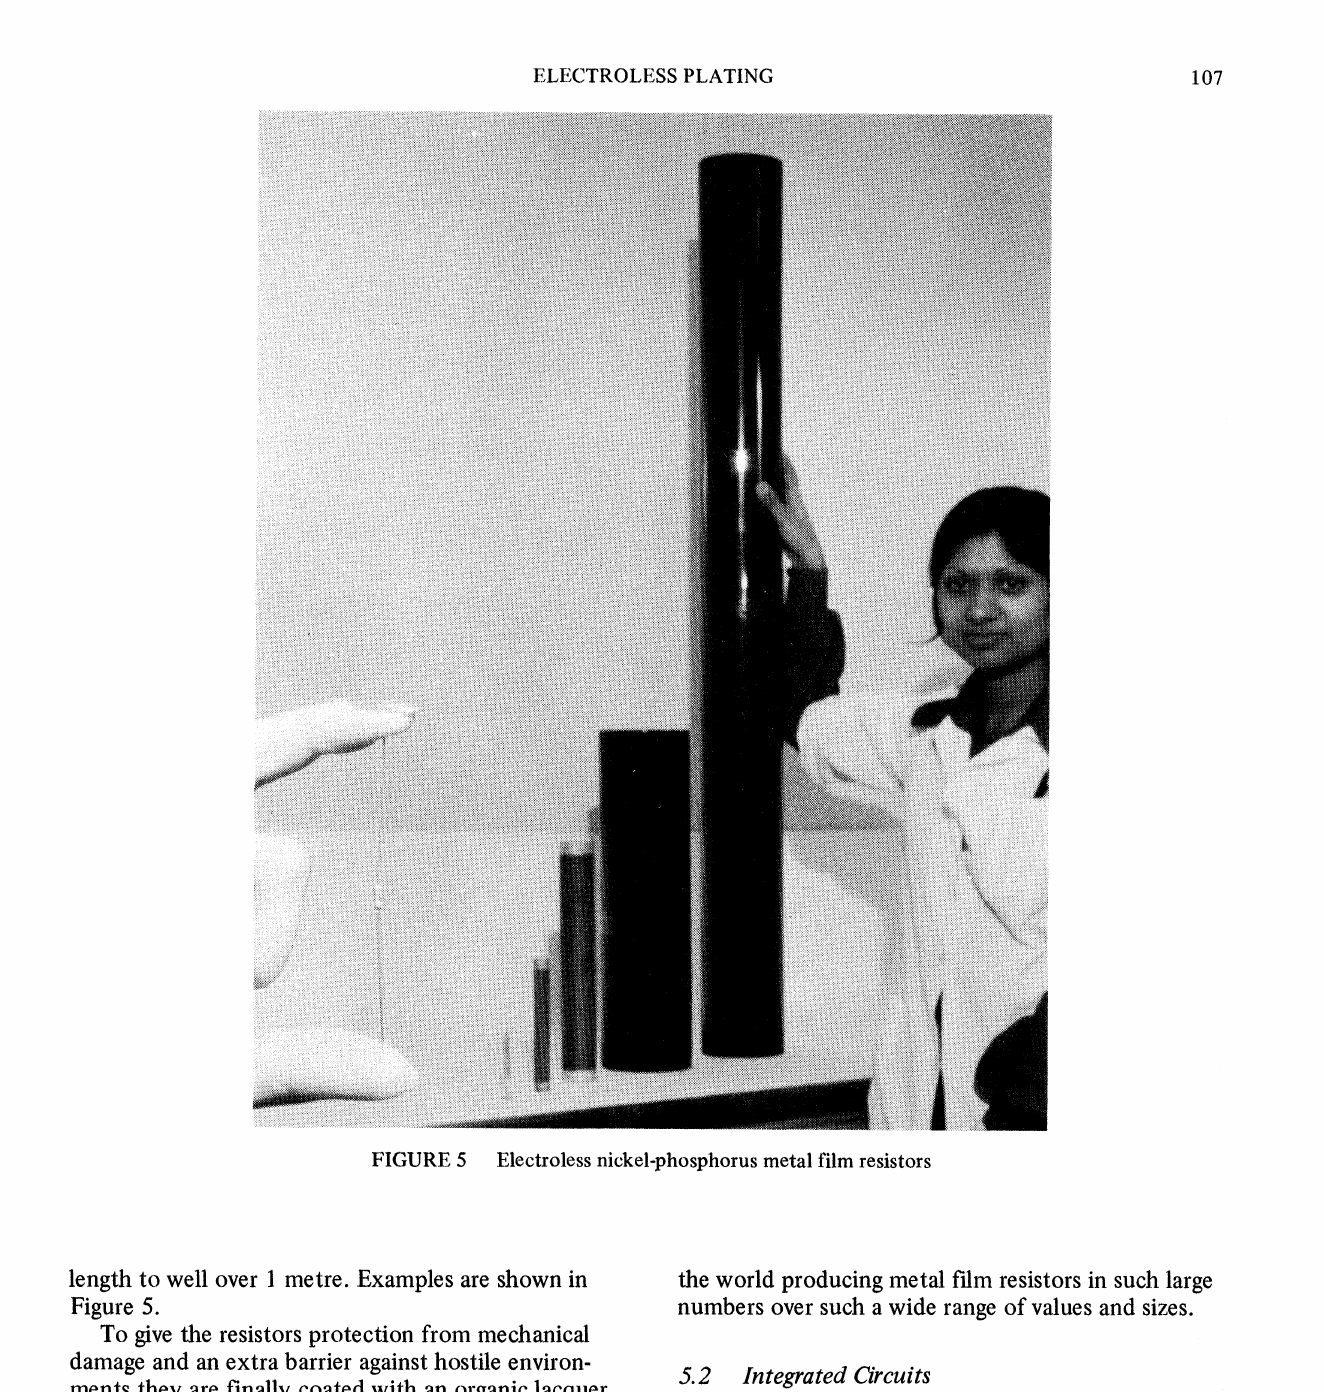
FIGURE 5 Electroless nickel-phosphorus metal film